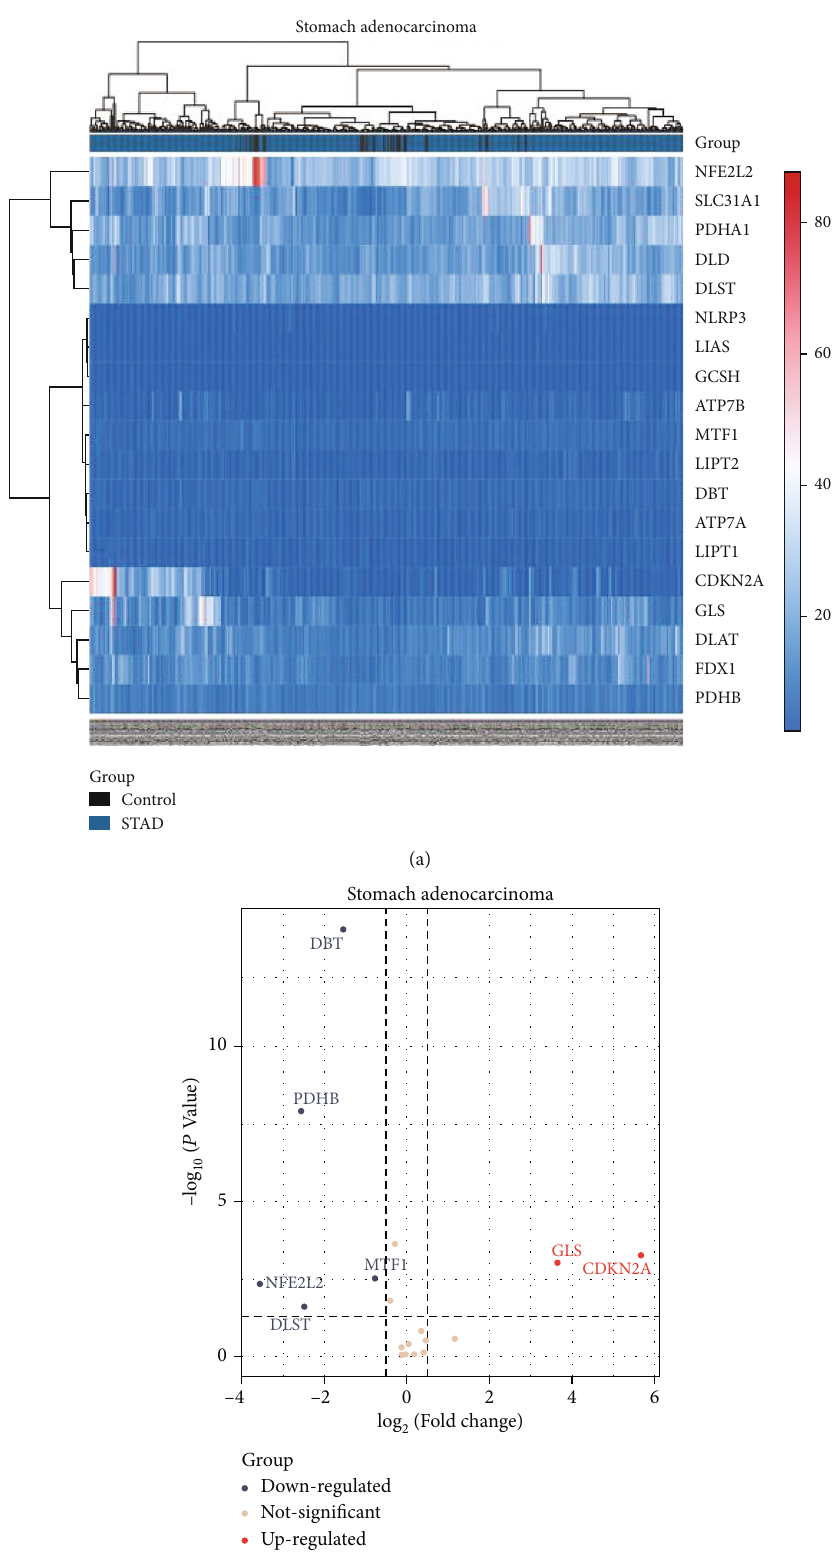
Figure 2: Di ff erentially expressed genes of cuprotosis in GC. (a) Heatmap of STAD cuproptosis-related gene clustering. (b) Volcano map of STAD cuproptosis-related gene